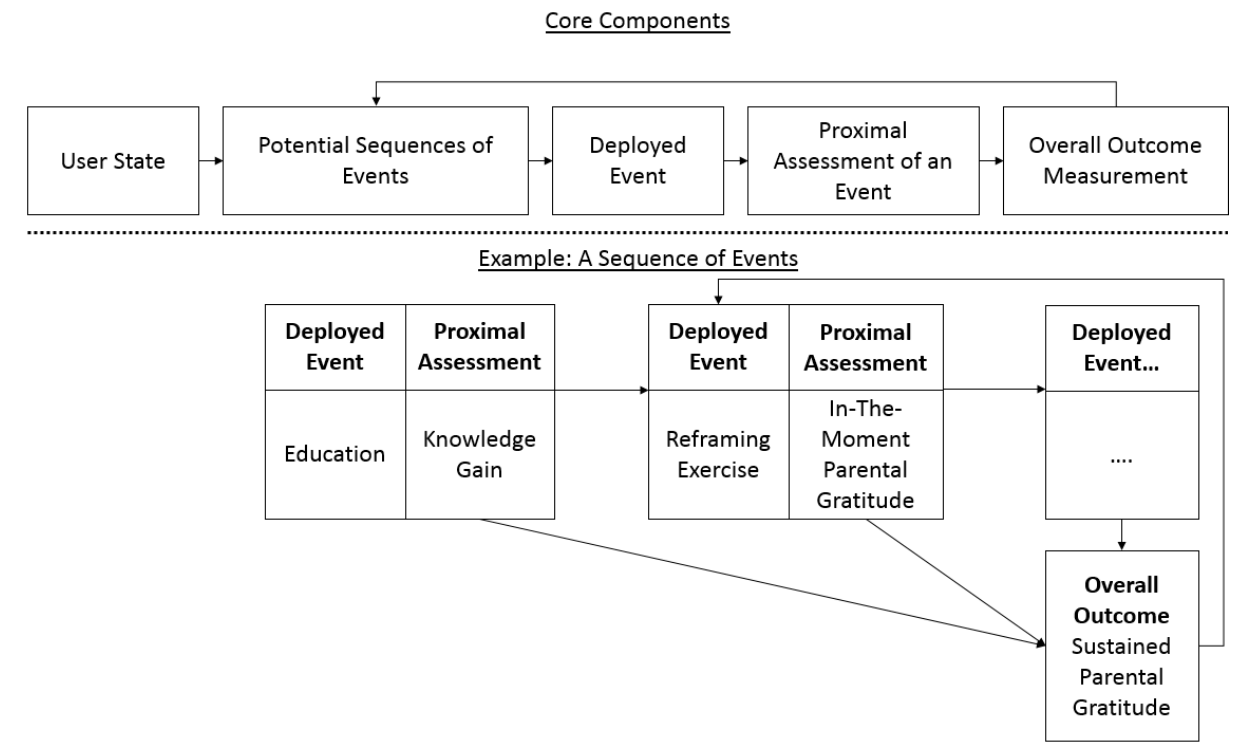
Figure 1. Illustration of a sequence of events based on decision